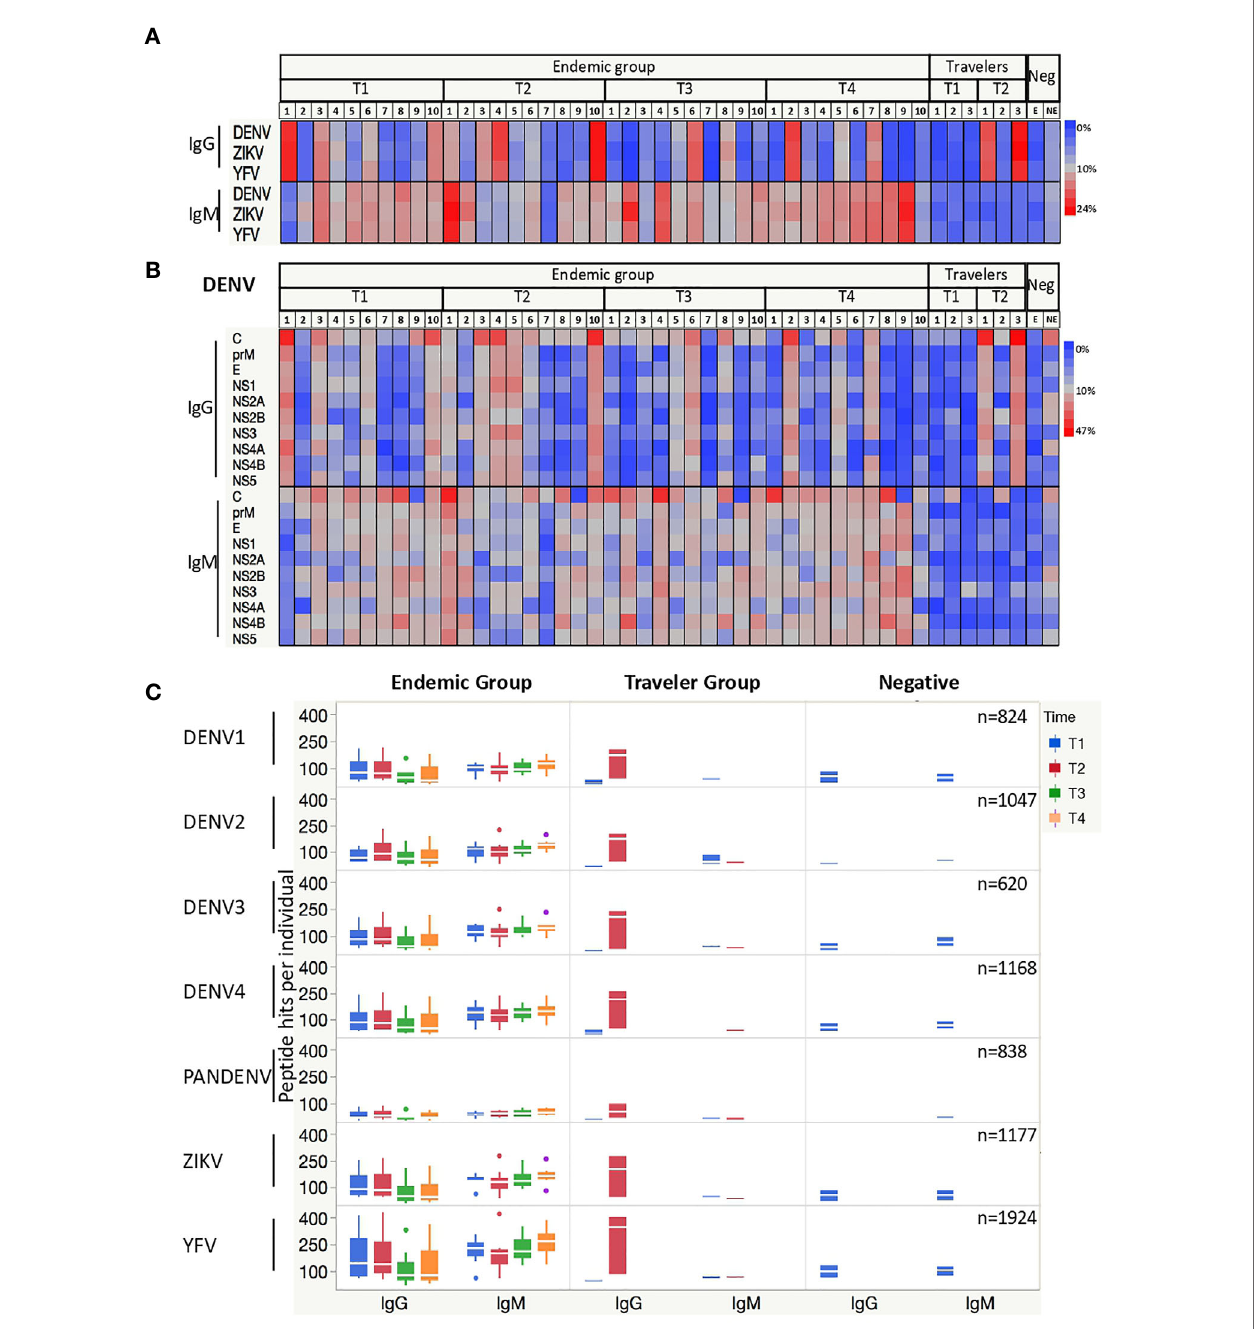
FIGURE 2 | Antibodies from DENV-infected individuals target epitopes in linear peptides from DENV, ZIKV and YFV. (A) Heatmaps depicting the relative number of peptides targeted by IgG and IgM Abs present in the sera from endemic (n=10) and travelers (n=3) at the time samples were collected: T1 (acute), T2 (early convalescent), T3 (mid convalescent) and T4 (late convalescent). Each column represents one sample. Samples from the negative subjects are the two last columns (E: endemic, NE: non-endemic). The color intensity indicates the relative number of 15-mer peptides from the indicated arbovirus against which IgG and IgM antibodies are reactive. (B) Heatmaps (as in A ) of the relative number of peptides from each DENV protein targeted by IgG and IgM Abs. Each column represents a sample, and each row represents a DENV protein. (C) Box plots illustrating the number of peptide hits targeted by IgG and IgM Abs present in the sera from DENV patients and negative samples. The box indicates the interquartile range, with the line at the median. The time points are color coded as follows: acute (blue box), early convalescent (red box), mid convalescent (green box) and late convalescent (orange box) samples. The boxes for the negatives are in blue. The numbers in the right corner in each row indicate the total number of peptides included in the microarray for each